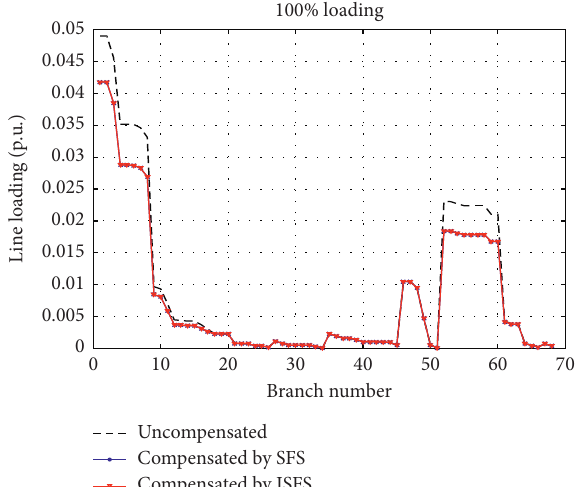
Figure 12: Line current of 69-bus network with 100% loading in scenario